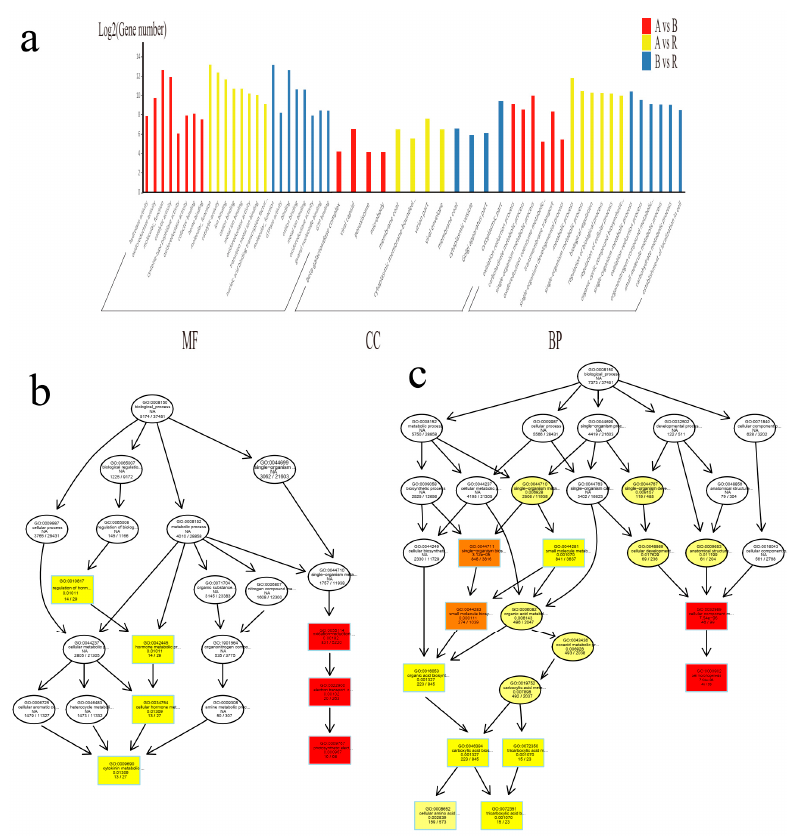
Figure 3. Functional analysis of di ff erentially expressed lncRNAs in A, B and R lines. ( a ) Gene ontology (GO) analysis of genes regulated by di ff erentially expressed lncRNAs in A, B and R lines; ( b ) GO enrichment analysis of genes regulated by di ff erentially expressed lncRNAs in A–B comparison; ( c ) GO enrichment analysis of genes regulated by di ff erentially expressed lncRNAs in A–R comparison.